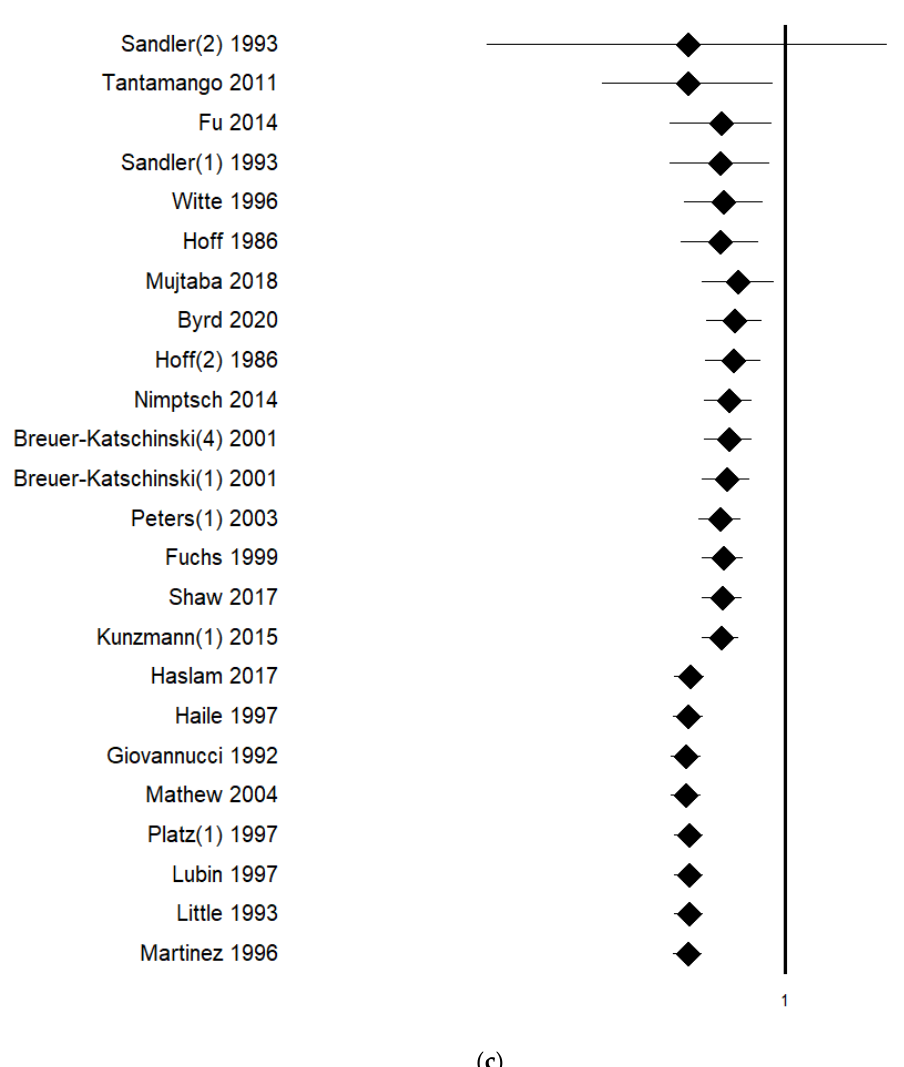
Figure 4. Forest plot of the cumulative analysis by ( a ) year of publication (from the first to the most recent published study), ( b ) by sample size (from the smallest to the largest), ( c ) dietary fibre dose (from the lowest to the highest intake) between dietary fibre intake and risk of colorectal adenoma. Diamonds represent the effect size esteemed using the cumulative analysis calculated adding one study at a time.